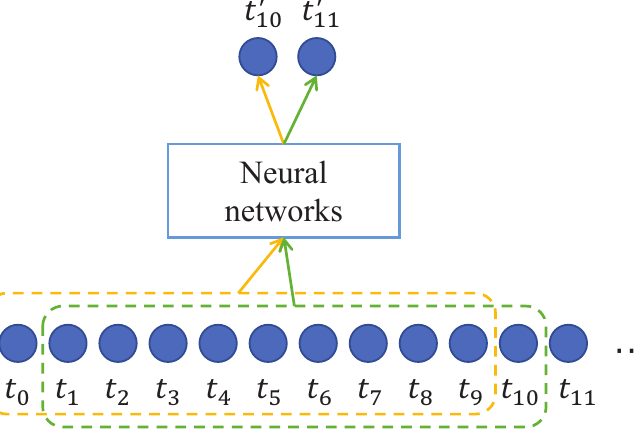
Figure 9. The predict mechanism of the neural